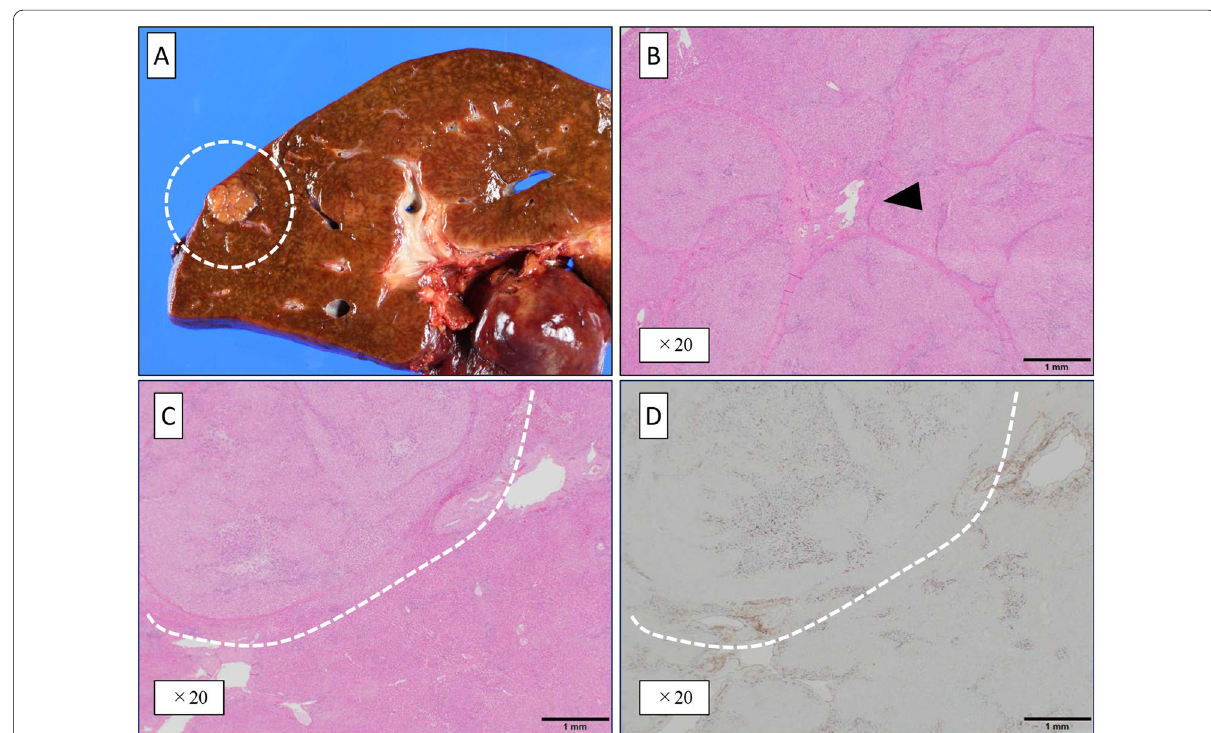
Fig. 3 A Nodular tumor site on resection specimen (circle). B Pathological diagnosis shows nodular lesions, and central scar (arrowhead) ( D CD34 immunostaining showed predominantly arteriogenesis in the nodules (circle) (